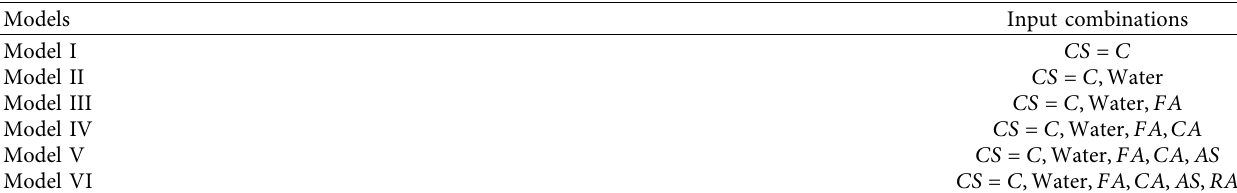
Figure 6: Correlation statistics between concrete parameters in the Table 2: The abstracted input combination using XGBoost model.